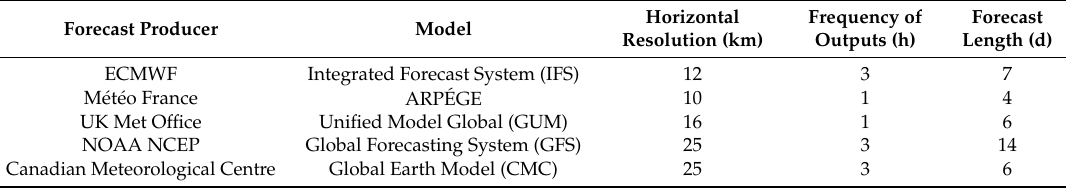
Table 1. Summary of the global forecast models and parameters of the forecast outputs.